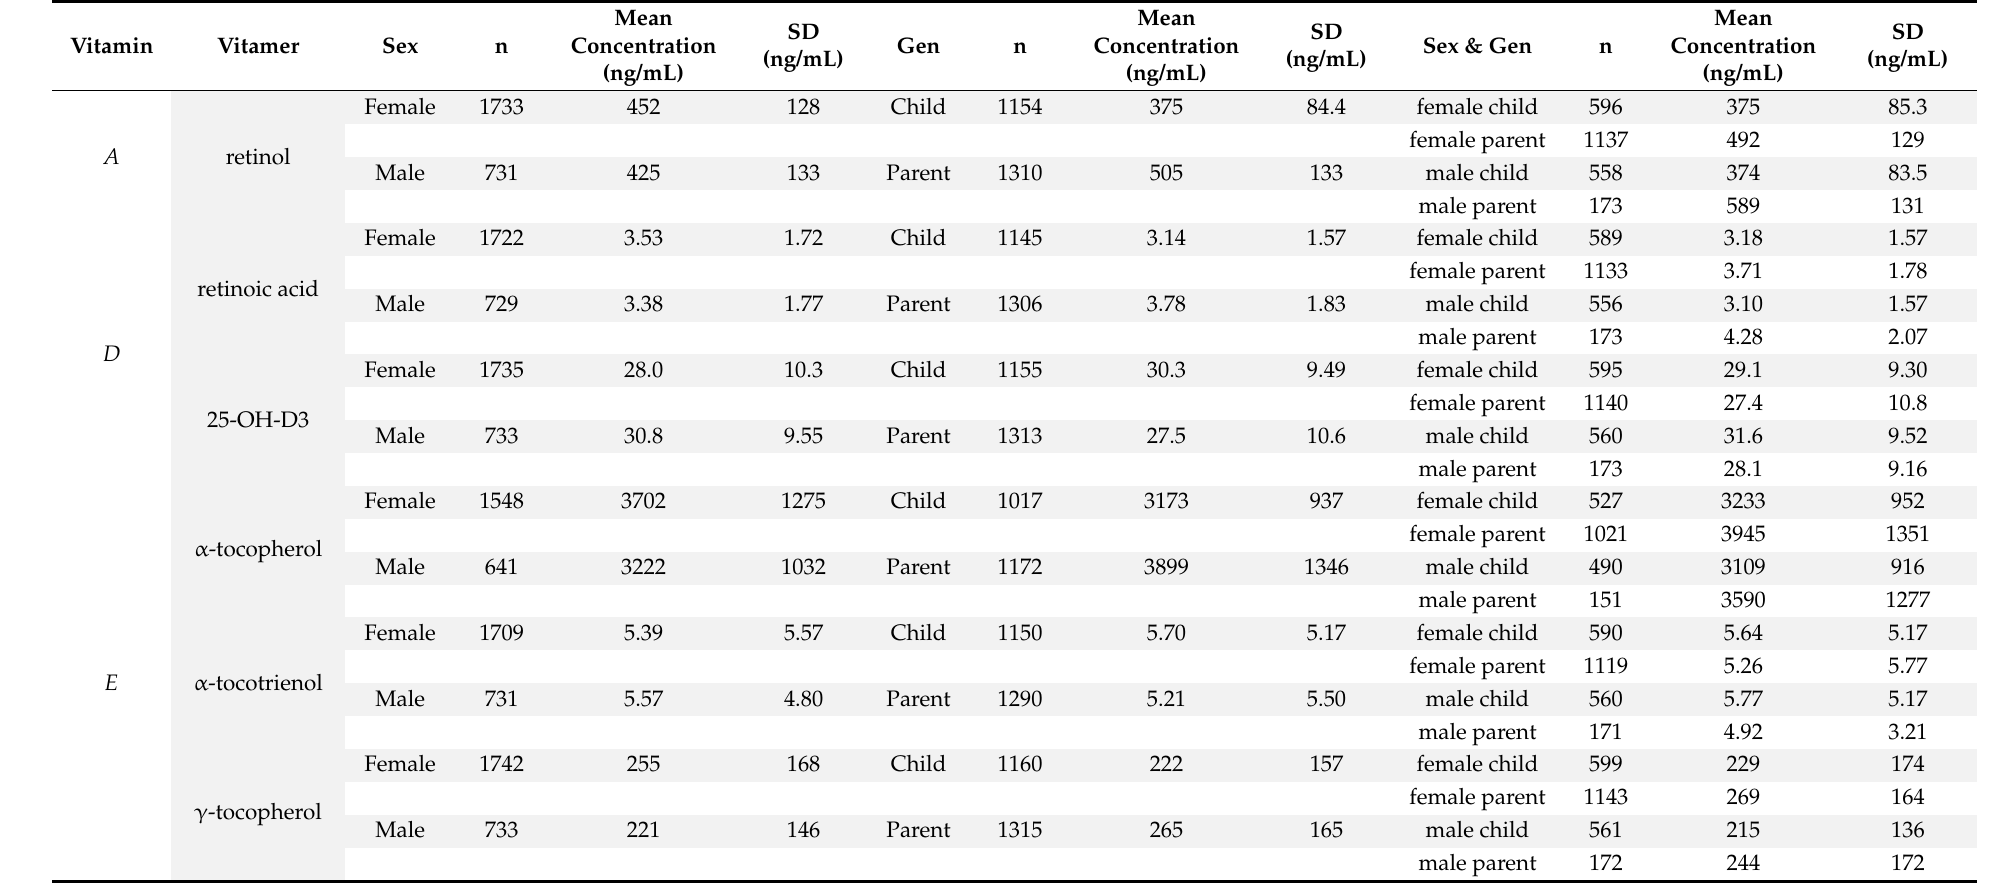
Table 1. FSV concentrations within the CheckPoint cohort differed by sex and generation. n, number of samples; Gen, generation; Sex, biological